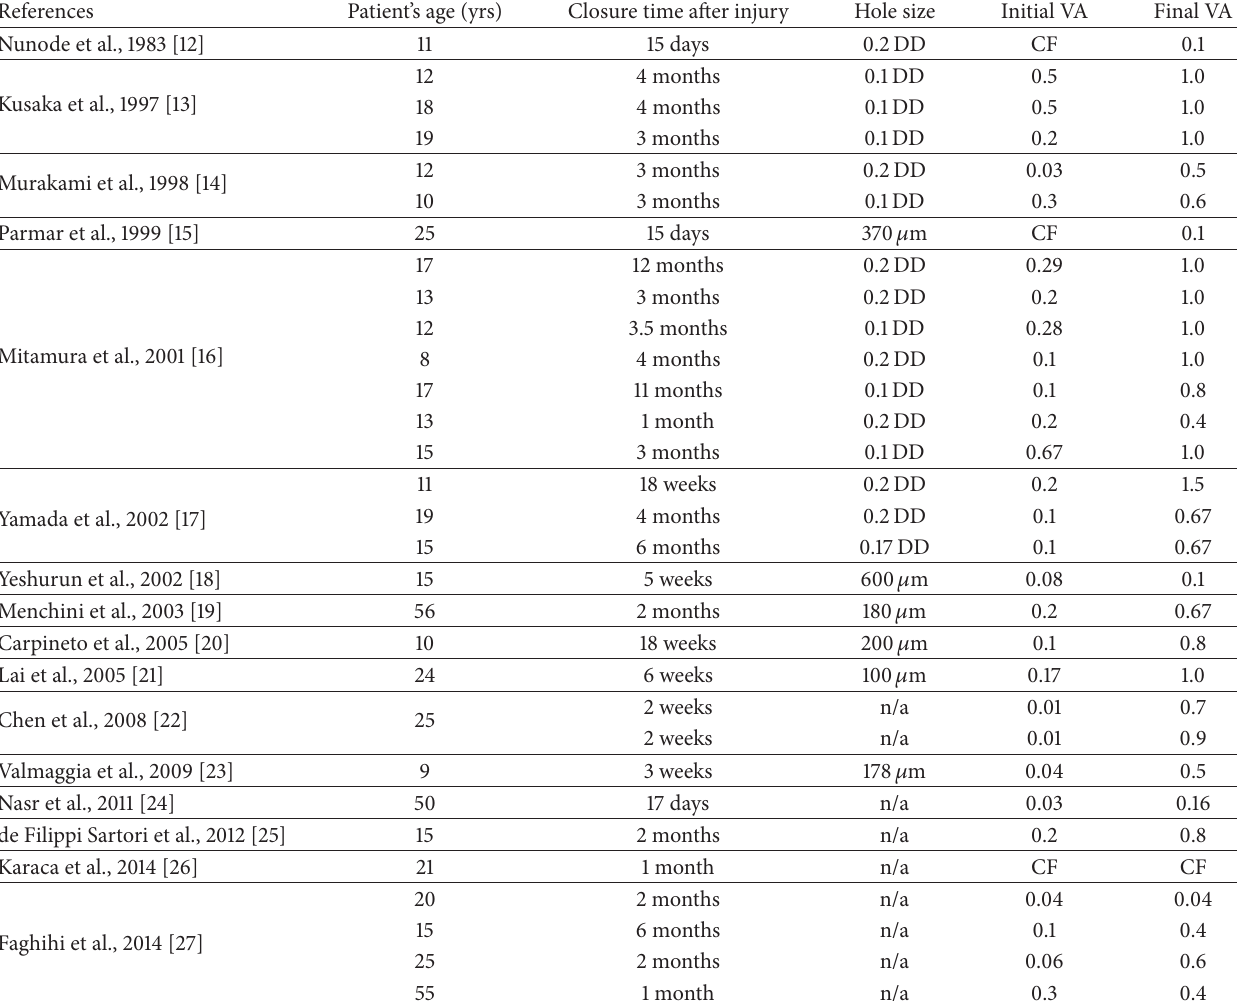
Table 1: Literature review of case reports on spontaneous closure of TMH.